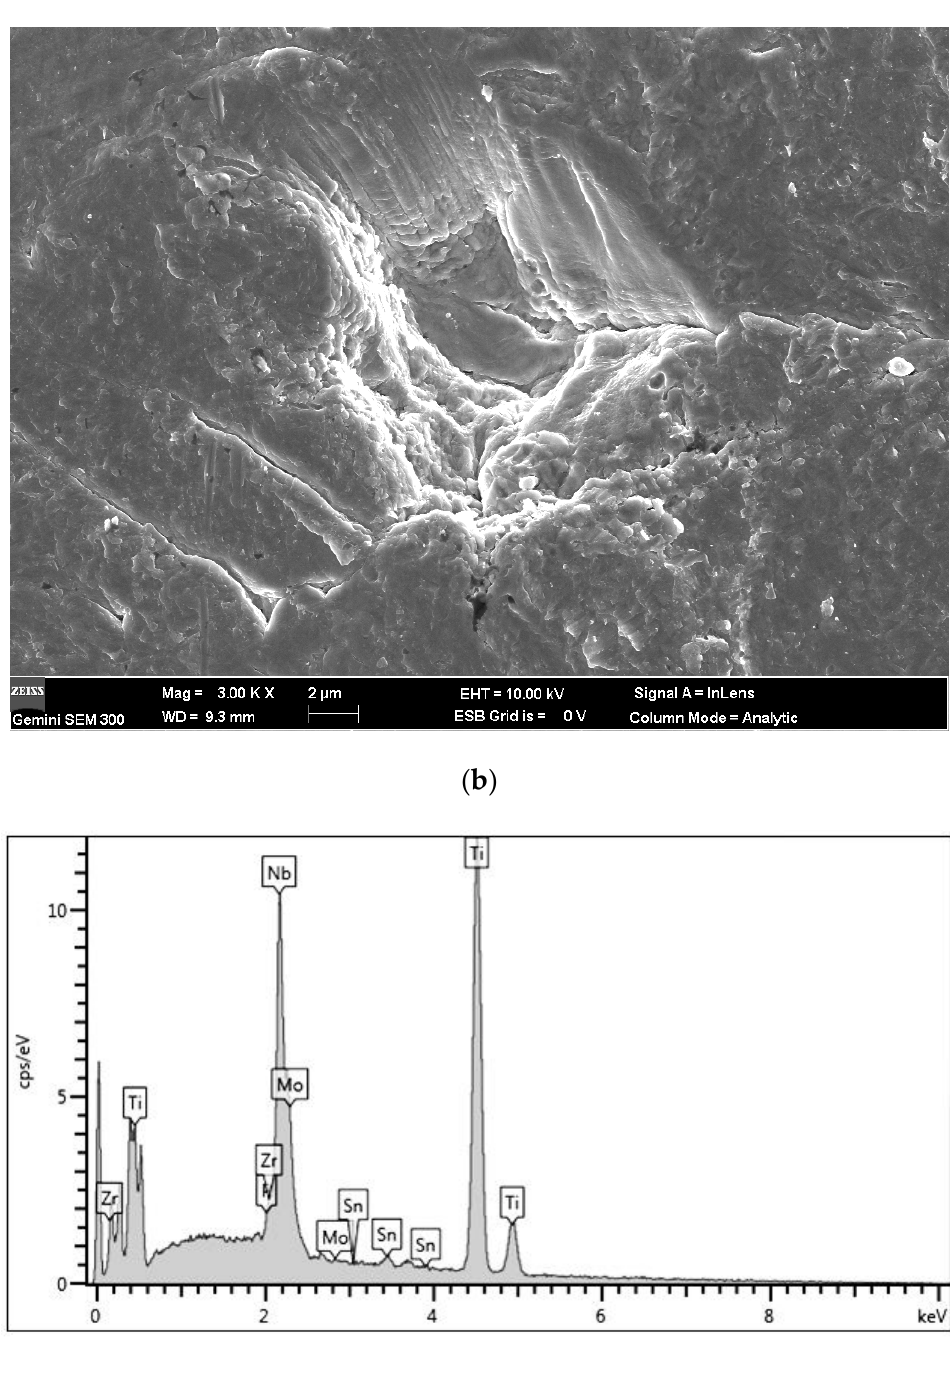
Figure 8. Fracture surface of TLM (UI-24000, 500 MPa, 1.86 × 10 6 cycles): ( a ) Overall view of fracture surface; ( b ) slip trace of crystals in the crack initiation; ( c ) EDX analysis of crack core.